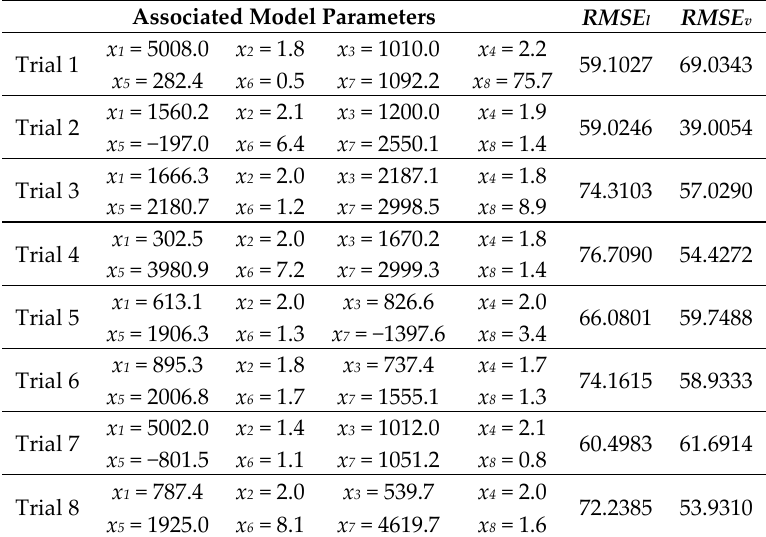
Figure 12. Results from estimating muscle torque of the rectus abdominis and erector spinae using the GA in Trial 2. Table 3. Results of estimations using the genetic algorithm (GA). RMSE : root-mean-square